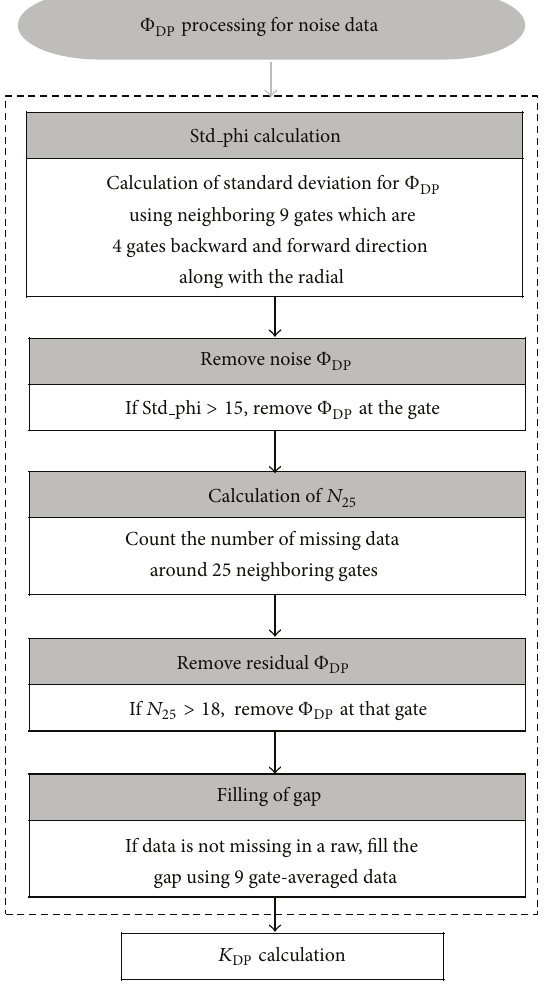
Figure 3: Noise removal flowchart for differential phase shift.